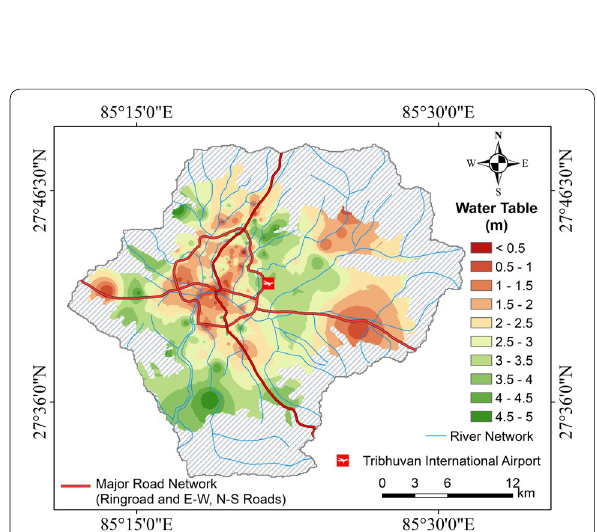
Fig. 6 Spatial mapping of the maximum groundwater level obtained by analyzing borehole data and map by Shrestha et al.